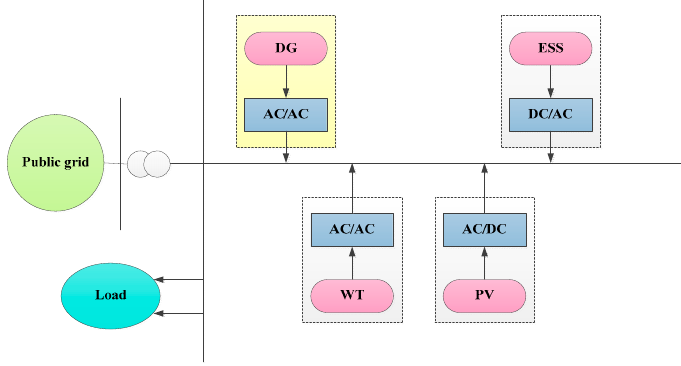
Figure 1. The structure of the microgrid system.